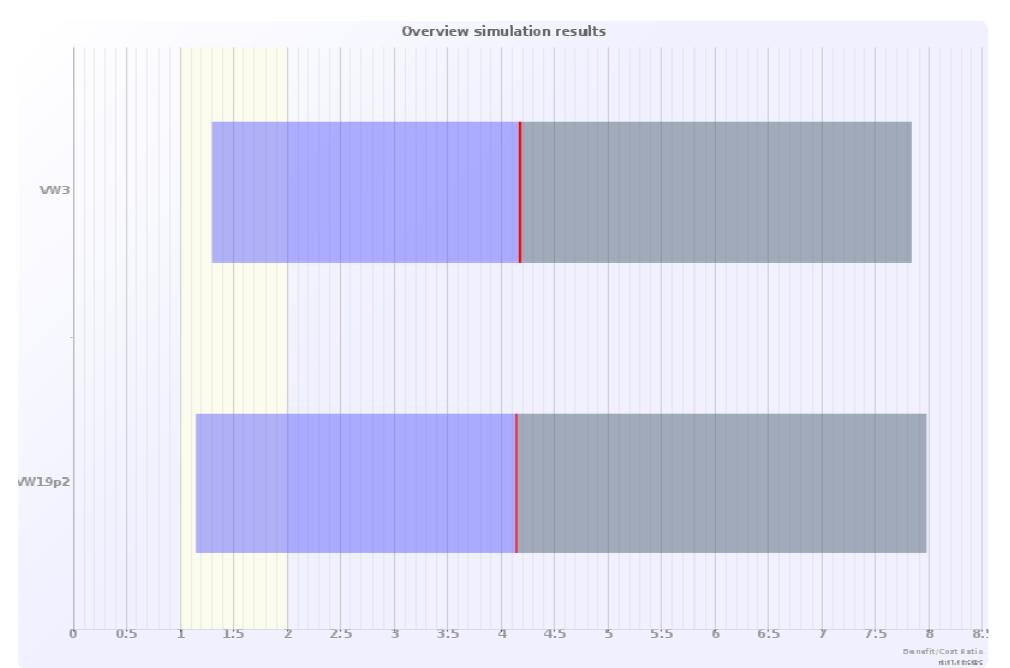
Figure 3. Monte Carlo simulations of benefit-cost (B/C) ratios, for the two demonstration projects with differently sized green walls—3 m high and 19.2 m high, assuming a green wall unit price of 2.4 EUR (2010) per m 2 per person per